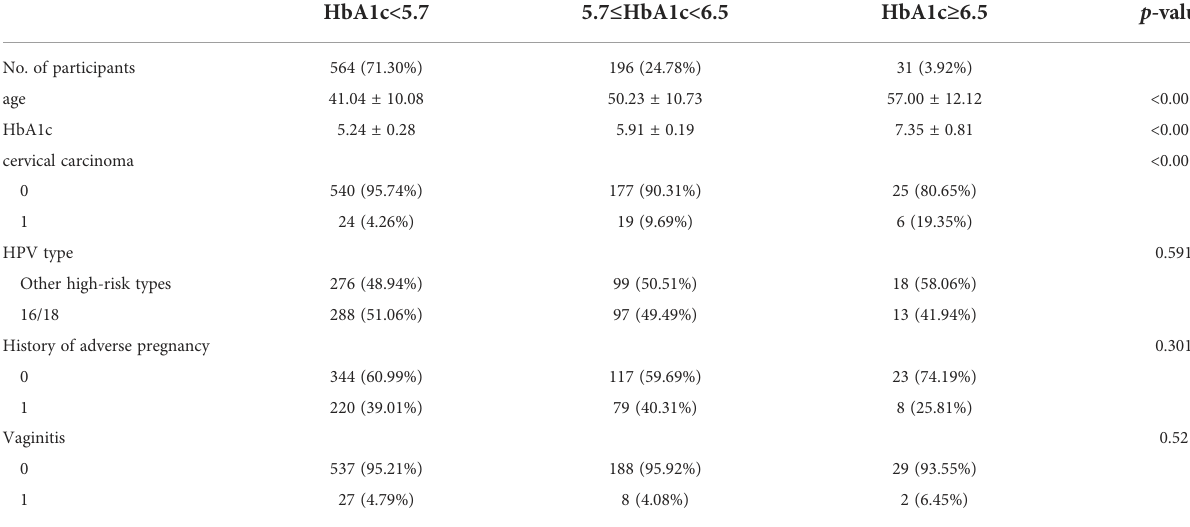
TABLE 1 Baseline characteristics of the study